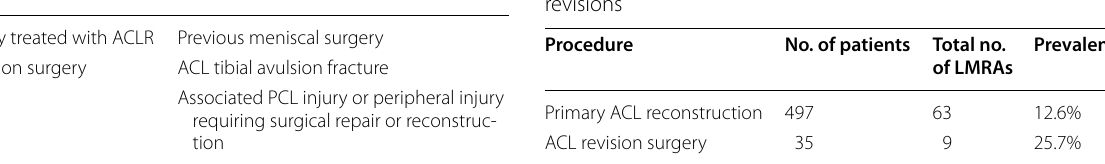
Table 1 Patient recruitment criteria for LMRA lesions Inclusion criteria